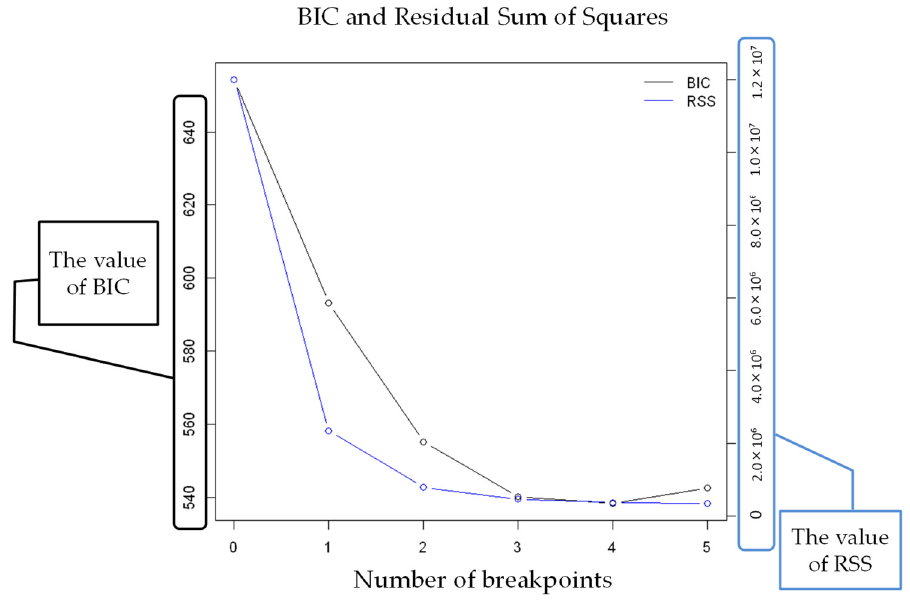
Figure 8. The number of breakpoints (VCO 2 ).